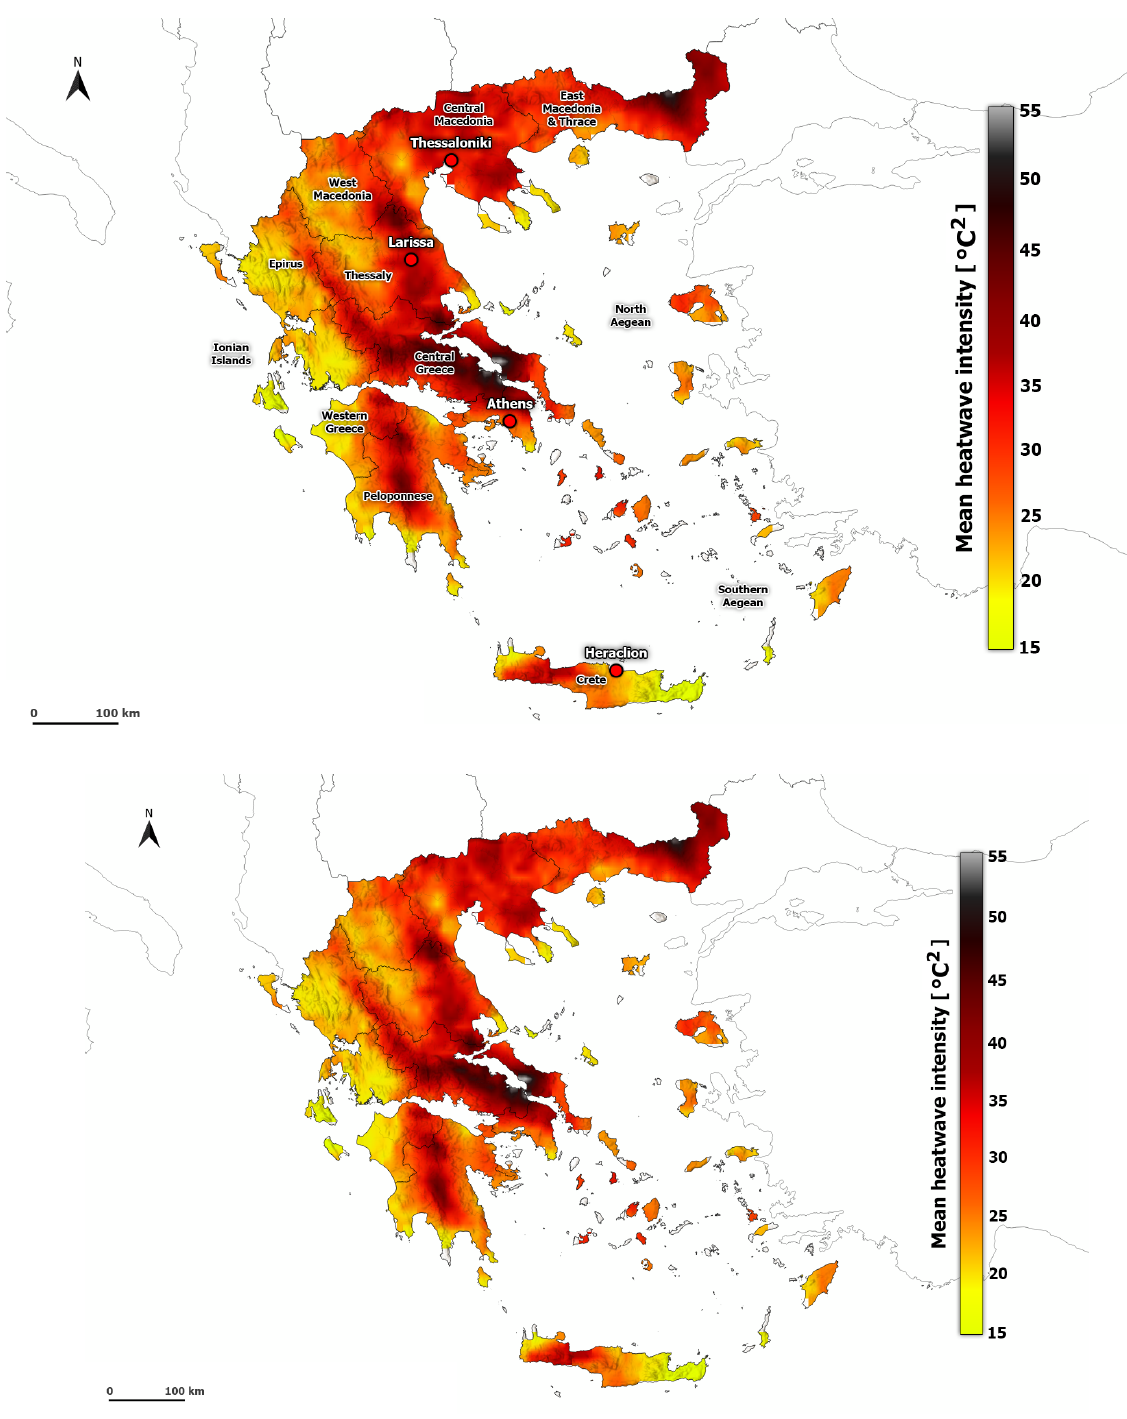
Figure 2. Spatial distribution of averaged HWI ( ◦ C 2 ) based on all heatwave events calculated from ERA5-Land during the period 1950–2020.